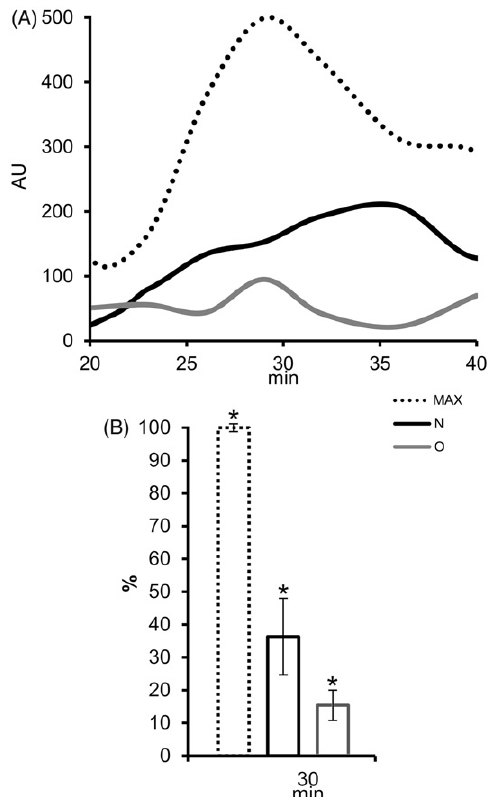
Figure 5. The effect of seminal prostasomes on reactive oxygen species (ROS) production in polymorphonuclear neutrophils (PMN). A: Kinetics of ROS produc- tion in PMN after activation with 12-myristate-13-acetate phorbol ester (PMA) alone (MAX) or in the presence of charge-resolved population of N and O, eluted with 1 M NaCl. B: Comparison of ROS production (%) in PMN after 30min of PMA addition, alone or in the presence of charge-resolved population of N and O, eluted with 1 M NaCl shows statistically significant decrease for all. The results are mean values of three experiments, and vertical bars present per- (cid:4) cent of standard deviation. Asterisk ( ) indicates P < 0.05. (AU ¼ arbitrary chemiluminescence units; N ¼ seminal prostasomes from normozoospermic men; O ¼ seminal prostasomes from oligozoospermic